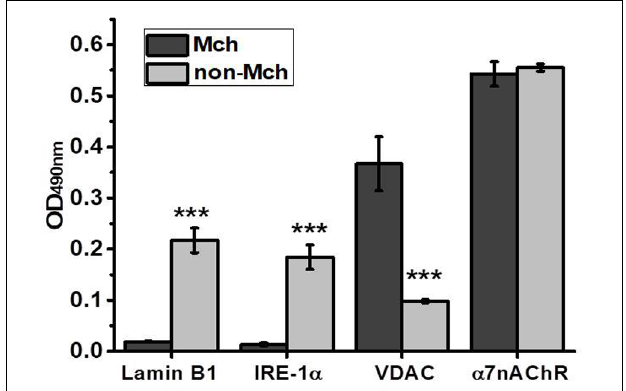
FIGURE 1 | ELISA assay characterizing the purity of mitochondria (Mch) vs. mitochondria-depleted (non-Mch) rat liver fractions. Each column corresponds to mean ± SE, n = 3; ∗∗∗ p < 0.0005 compared to Mch